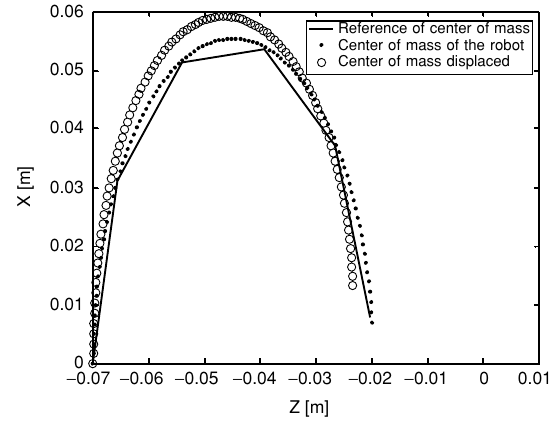
Figure 8 Torques for the frontal plane ( (cid:7) 5 ) and sagital plane ( (cid:7) 6 ) calculated with both controllers.